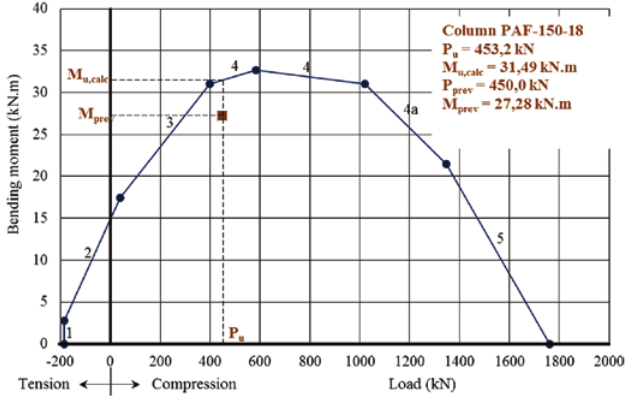
Figure 15 N-M Interaction diagram for column PPBA-150-18